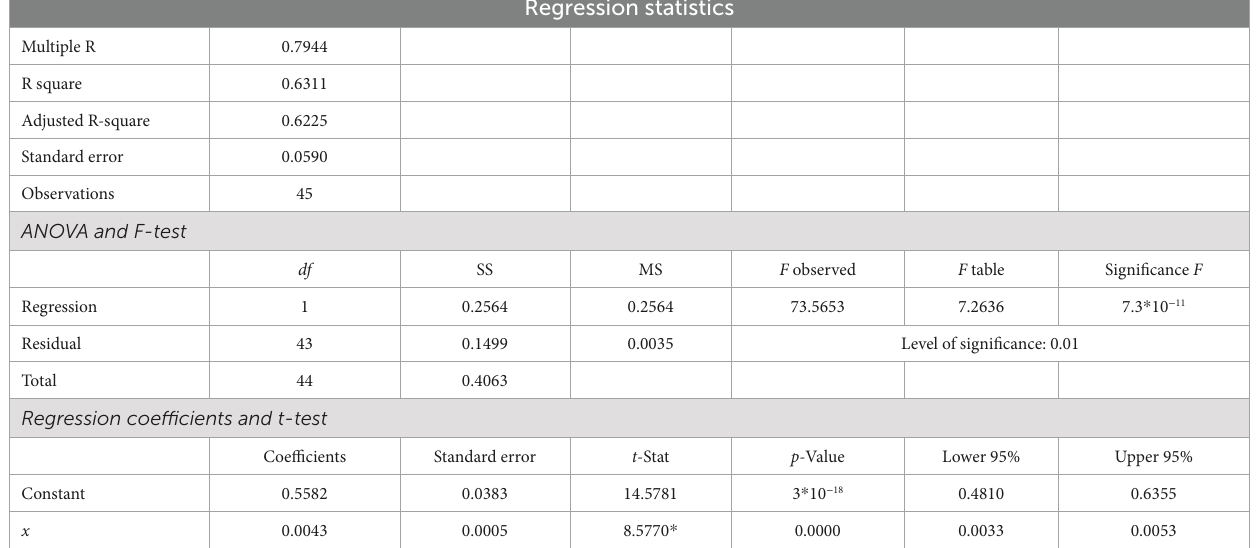
TABLE 2 Regression dependence of the human development index on knowledge (digital competitiveness index) for the entire sample in